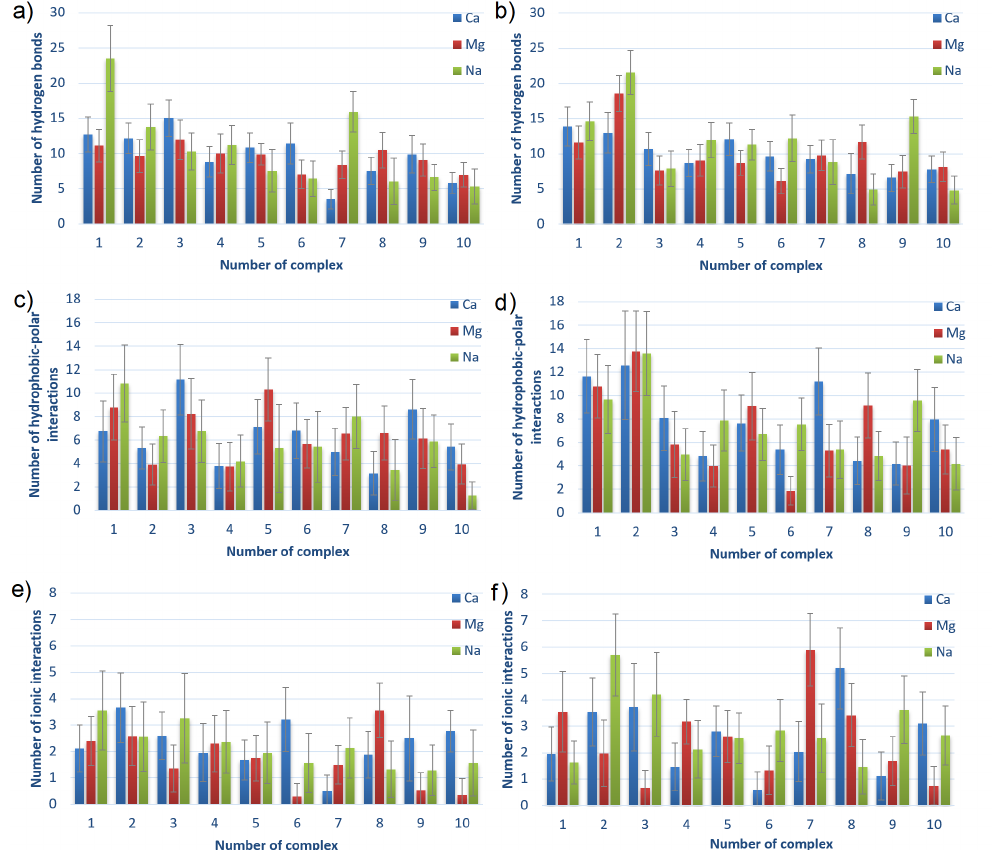
Figure 8. Intermolecular HBo, HP and ionic interactions for HSA:CS-6 ( a , c , e ) and HSA:CS-4 ( b , d , f ) complexes. The complexes are sorted from lowest to highest averaged energy of binding after MD simulations; thus, the strongest bound are first (cf., Table 1). Error bars present doubled